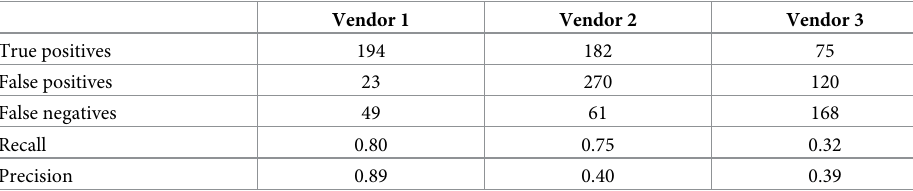
Table 1. Vendor lung nodules detection